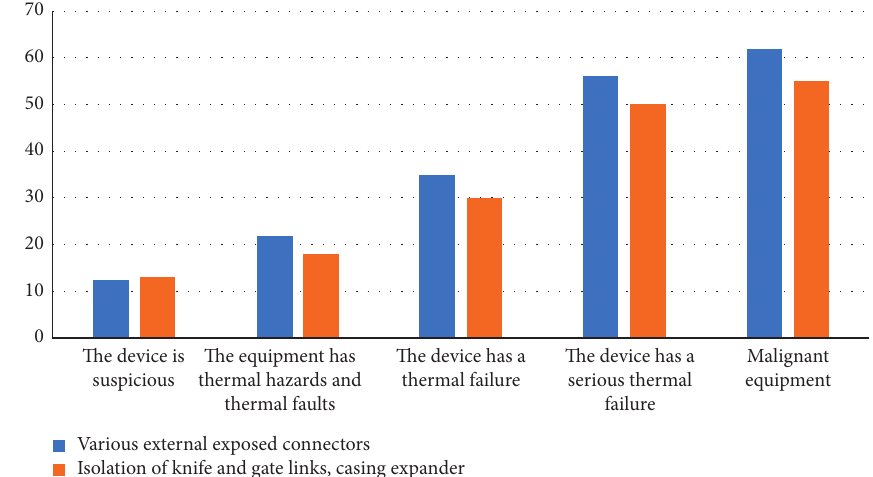
Figure 2: Criteria for the detection of exterior thermal faults (temperature difference between the hot spot and lowest temperature point) ( °